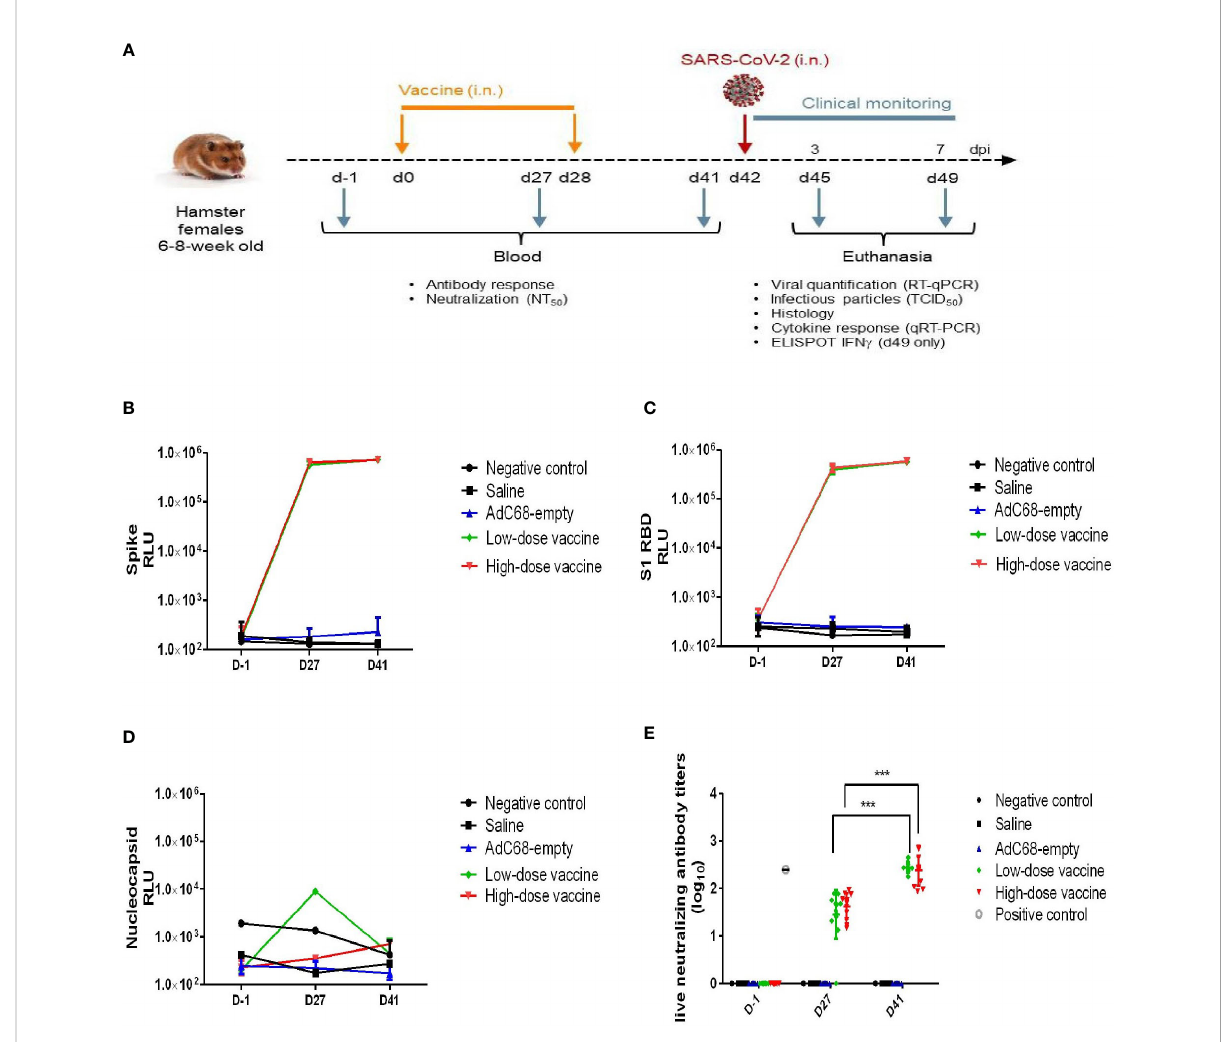
FIGURE 2 Experimental study scheme and anti-SARS-CoV-2 antibody detection. (A) Schedule of vaccine administration and virus challenge. dpi (days post- infection). (B) Binding anti-spike IgG antibody in golden Syrian hamsters ’ sera. The antibody level was determined by Multiplex ELISA. (C) Binding anti-S1 RBD IgG antibody in golden Syrian hamsters ’ sera. The antibody levels were determined by Multiplex ELISA. (D) Anti-nucleocapsid IgG antibody in golden Syrian hamsters ’ sera. The antibody level was determined by Multiplex ELISA. (E) Live neutralizing antibody titers in golden Syrian hamsters ’ sera. The neutralizing antibody level was determined by live SARS-CoV-2 cytopathogenicity-based assay. *** p <